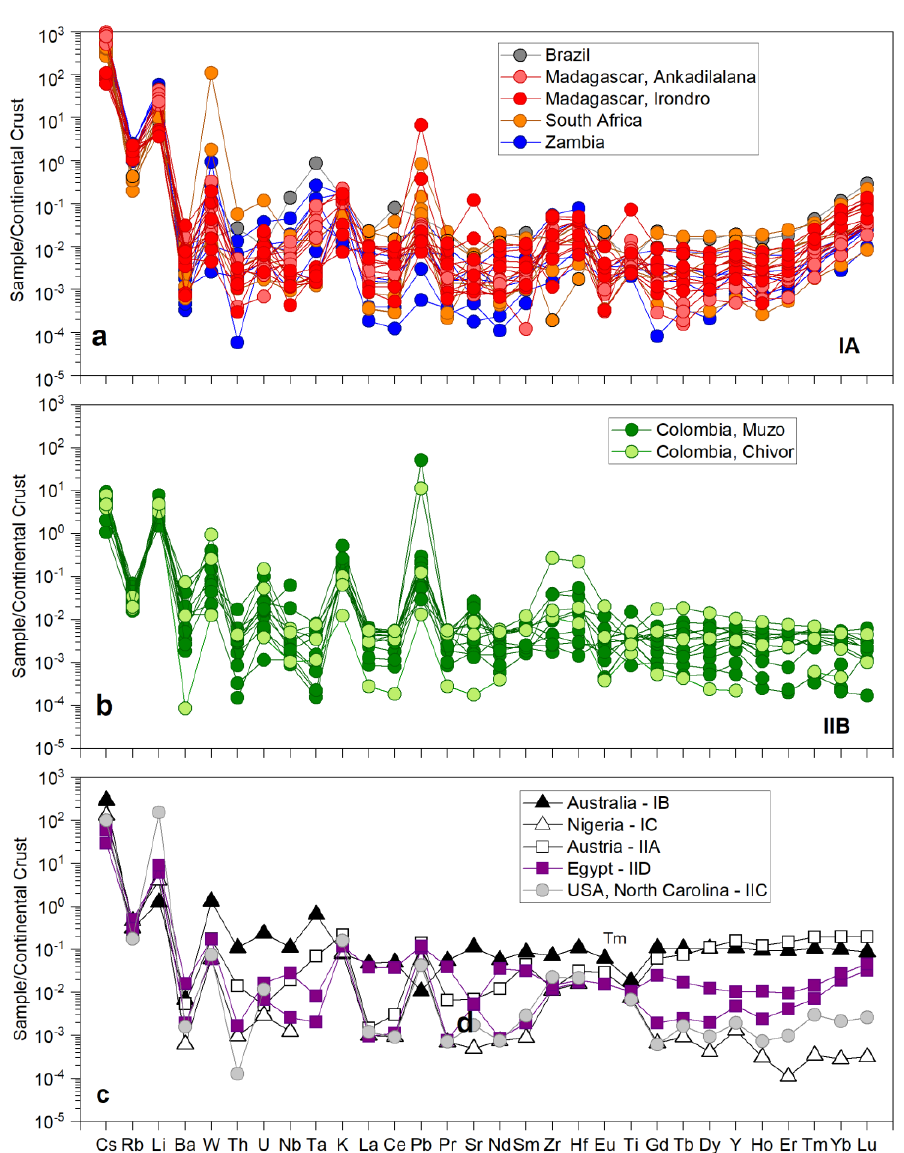
Figure 4. Multi-incompatible trace element (ITE) patterns; ( a ) ITE patterns for type IA emeralds; ( b ) ITE patterns for type IIB emeralds; ( c ) ITE patterns for type IB, IC, IIA, IID and IIC emeralds. Elements are ordered by relative incompatibility and normalized to continental crust composition [28] .